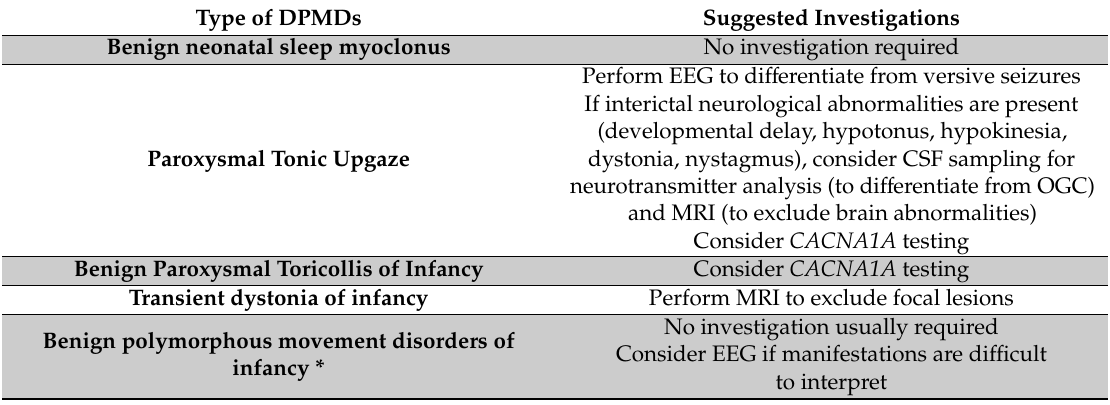
Table 3. Suggested investigations in Developmental Paroxysmal Movement Disorders